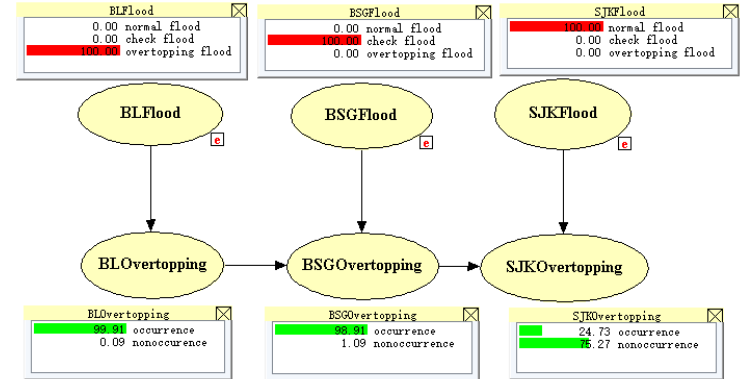
Figure 20. The posterior probability of each dam’s overtopping node on the condition of Flood evidence.